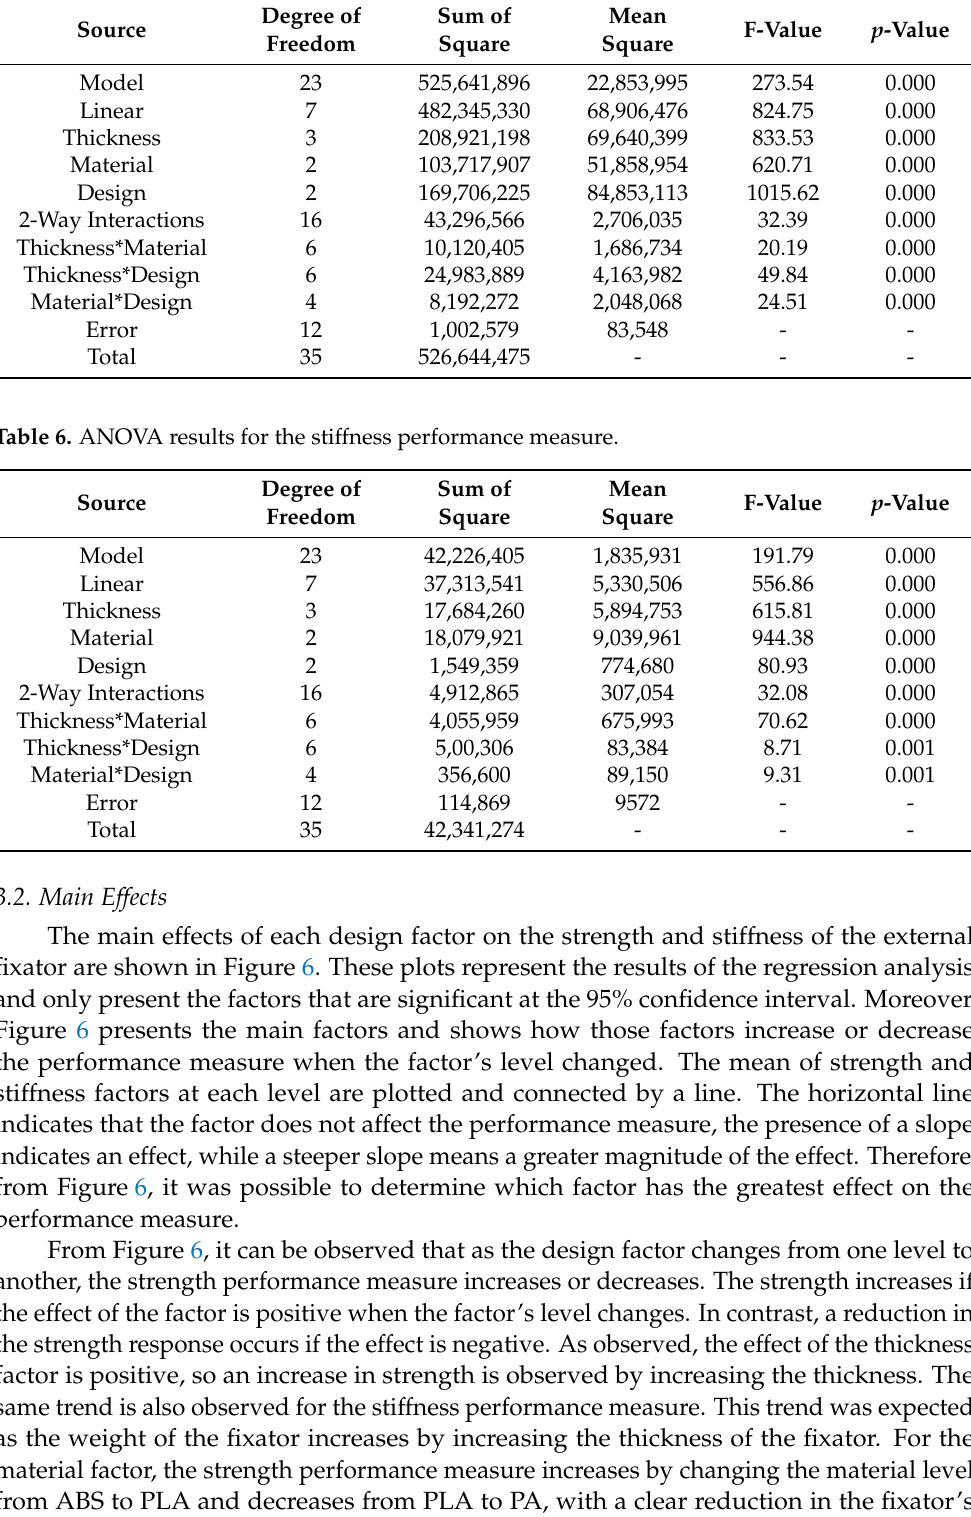
Table 5. ANOVA results for the strength performance measure.